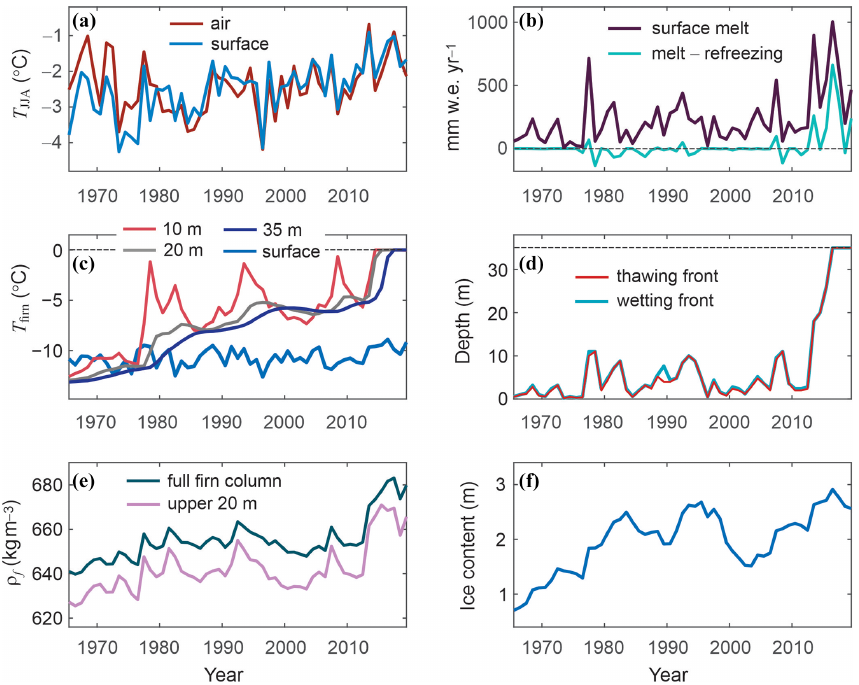
Figure 5. Modelled meteorological, surface mass balance, and firn conditions from 1965 to 2019: (a) summer (JJA) air and snow surface temperatures ( ◦ C); (b) annual melting and “drainage” (melting minus refreezing; mmw.e.yr − 1 ); (c) annual mean snow and firn temperature at the surface (0.1m) and at depths of 10, 20, and 35m ( ◦ C); (d) modelled maximum depths of the summer wetting and thawing fronts (m); (e) average firn density for the full firn column and in the upper 20m (kgm − 3 ); (f) total firn ice content